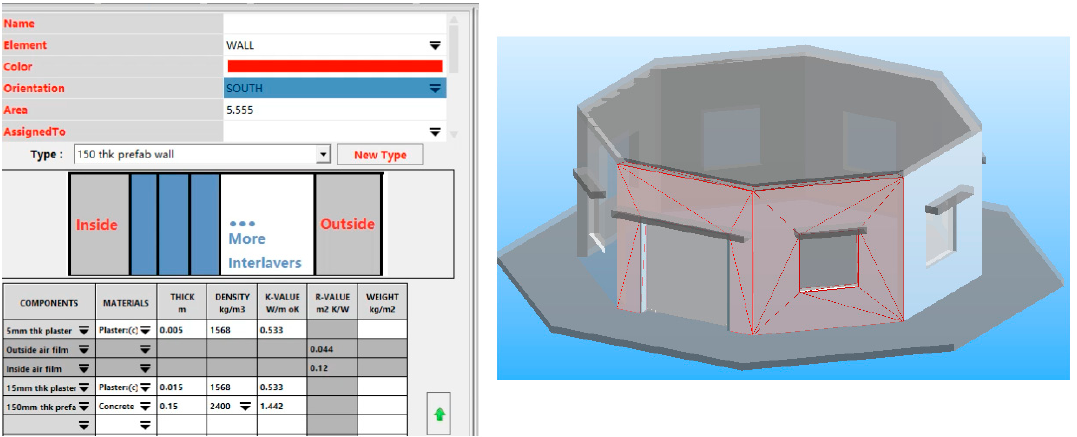
Figure 3. Selecting and assigning parameters for the elements with the same properties.